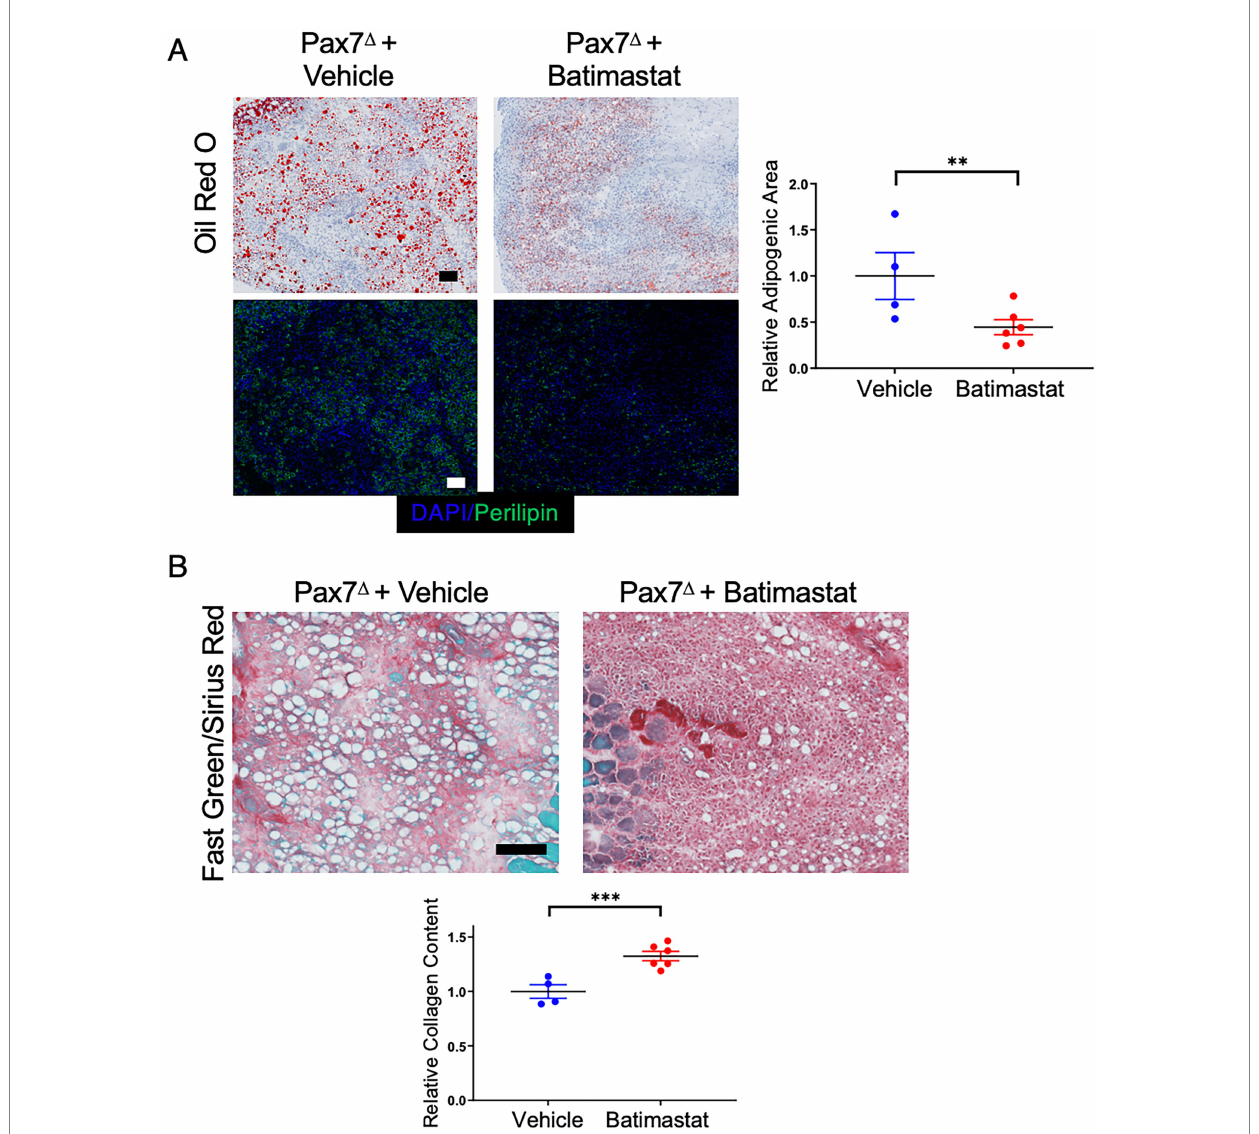
FIGURE 7 Inhibiting FAPs with batimastat reduces adipogenesis and increases fibrosis after HLI in the absence of satellite cells. (A) Batimastat treatment significantly decreased total fat in Pax7 Δ ischemic TA muscle as determined by oil red O and perilipin staining 7 days after HLI surgery. (B) Fast Green/ Sirius Red staining demonstrated a corresponding significant increase in collagen content in Pax7 Δ ischemic TA muscle, consistent with a switch from adipogenesis to fibrosis after inhibition of FAPs ( n = 4–6 per group). Scale bars = 100 μ m. All data shown are normalized means +/ − SEM. ** p < 0.01; *** p < 0.001 by 2-sided t